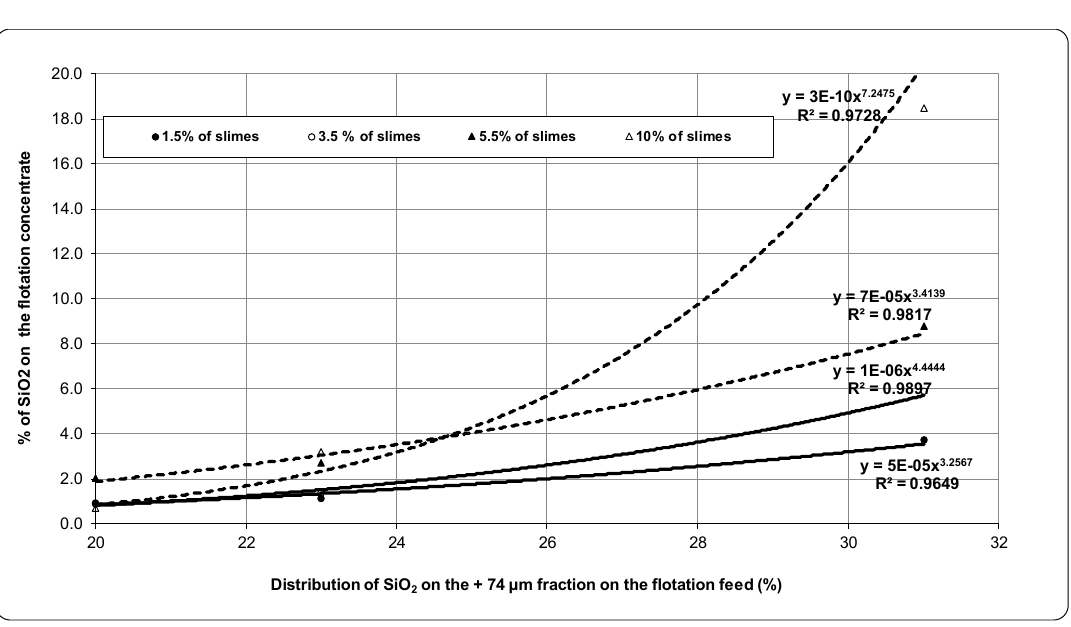
Figure 6. Combined effect of the SiO 2 distribution in the +74 µm fraction and the presence of slimes on the flotation response.